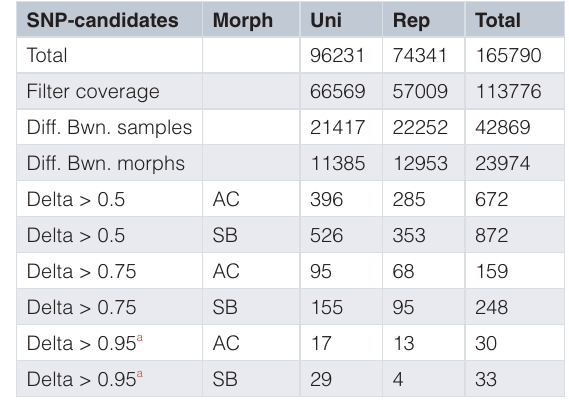
Table 4. Candidate SNPs in the Arctic charr transcriptome, filtered by coverage, difference between sample and morphs and frequency difference between